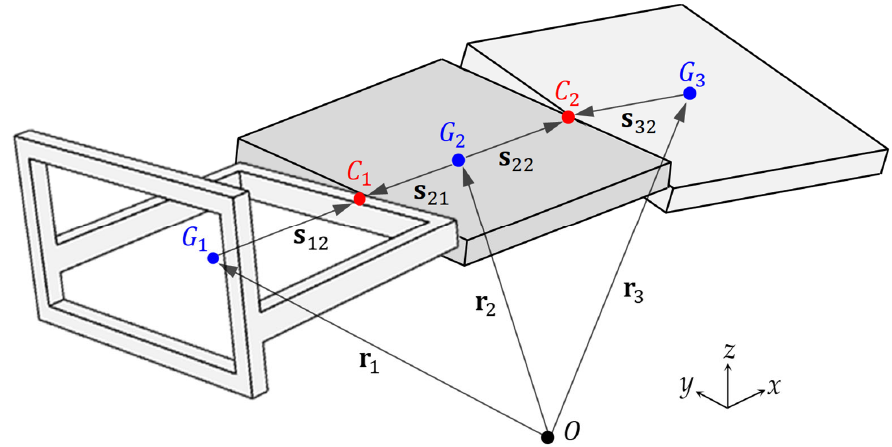
Figure 16. Constraints between the front, middle, and rear body floors.